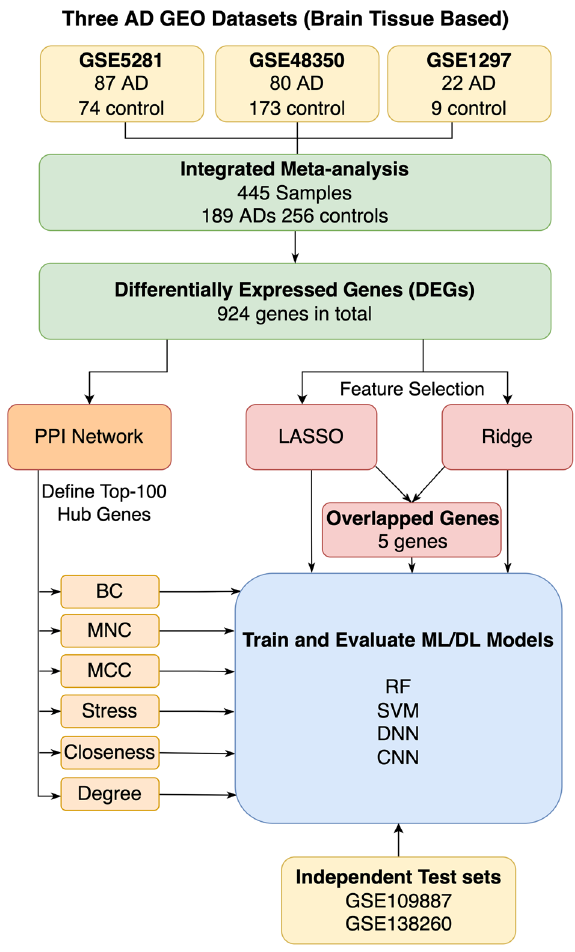
Figure 1. The study workflow consists of two key paths, via ranking algorithms and feature selection